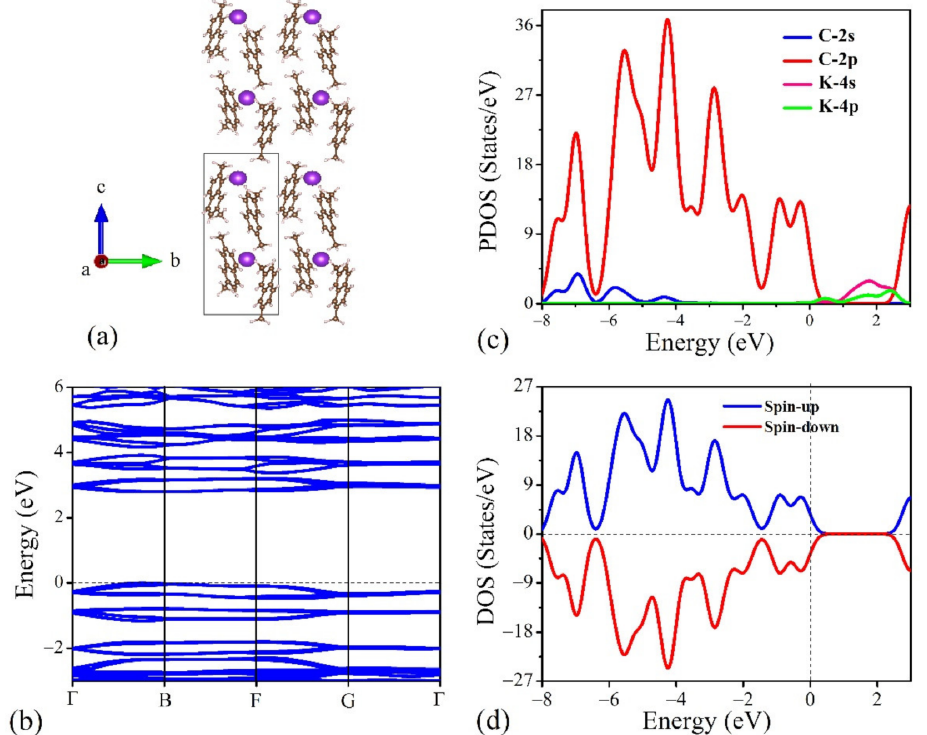
Figure 3. ( a ) The calculated potassium-intercalated 2,7-DMN structure is shown in a 2 × 2 × 2 supercell. The purple balls represent potassium atoms, and the brown balls represent carbon atoms. ( b ) The band of the theoretical model. ( c ) The relationship between Orbital-resolved partial density of states (PDOS) and the energy of theoretical model. ( d ) The relationship between spin-dependent density of states (DOS) and the energy of theoretical